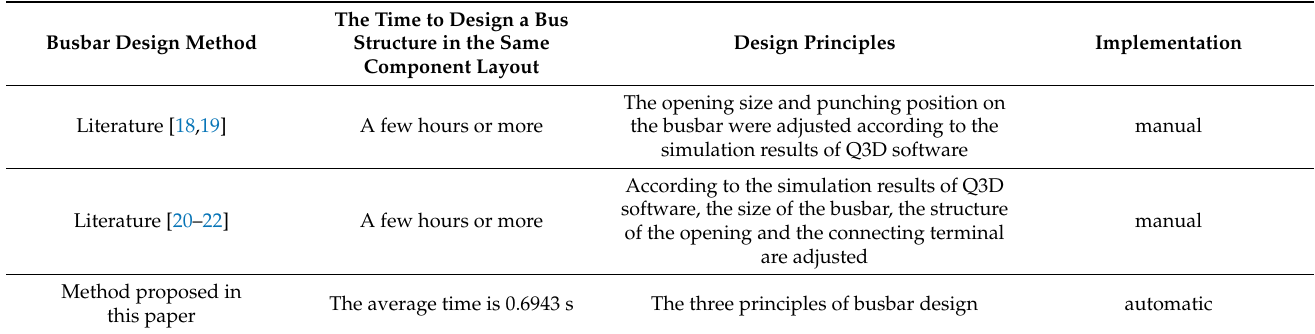
Table 5. Comparison of busbar design methods among different